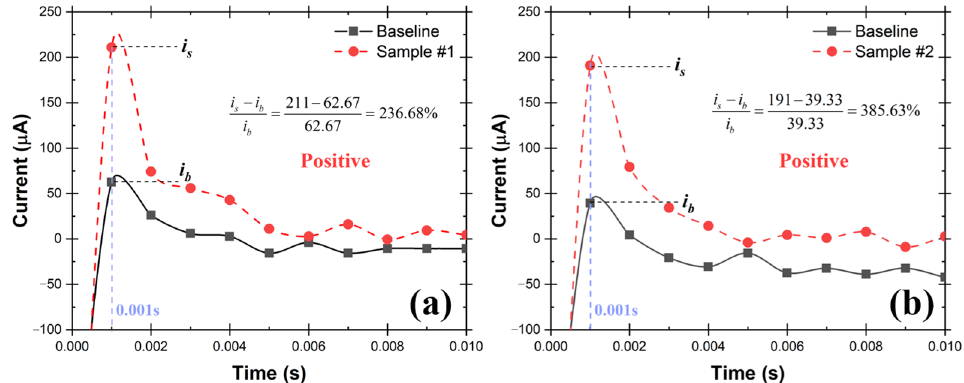
Figure 9. ( a ) Schematic of the test rig using TSI Atomizer and Liquid Spot Sampler. ( b ) Picture of the experimental setup used in the test rig.